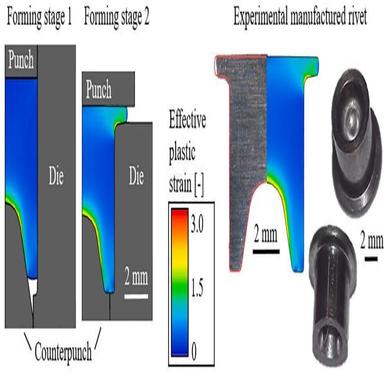
Design and result of the experimental manufacture of the new rivet.